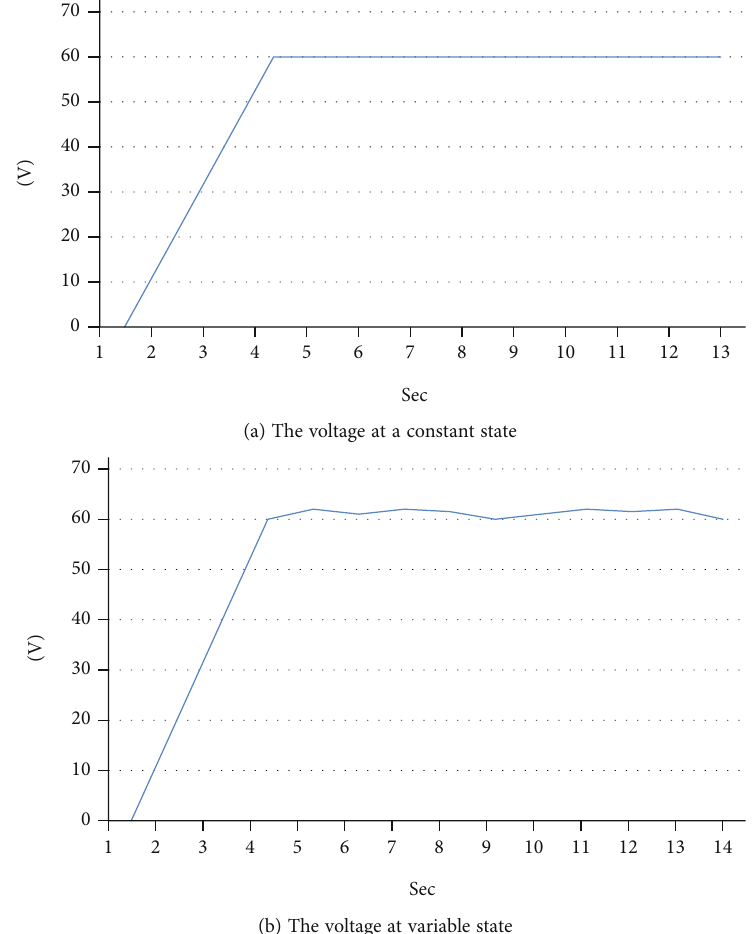
Figure 8: A voltage of DC